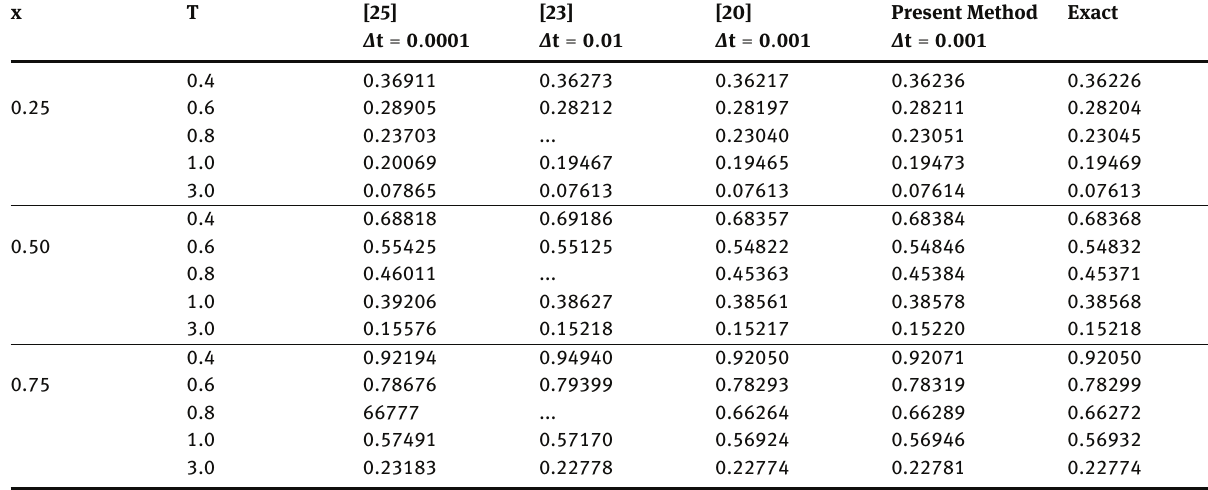
Table 8: Comparison between exact and existing numerical solutions of Example 2 for ν = 0.01 at different times T and x . x